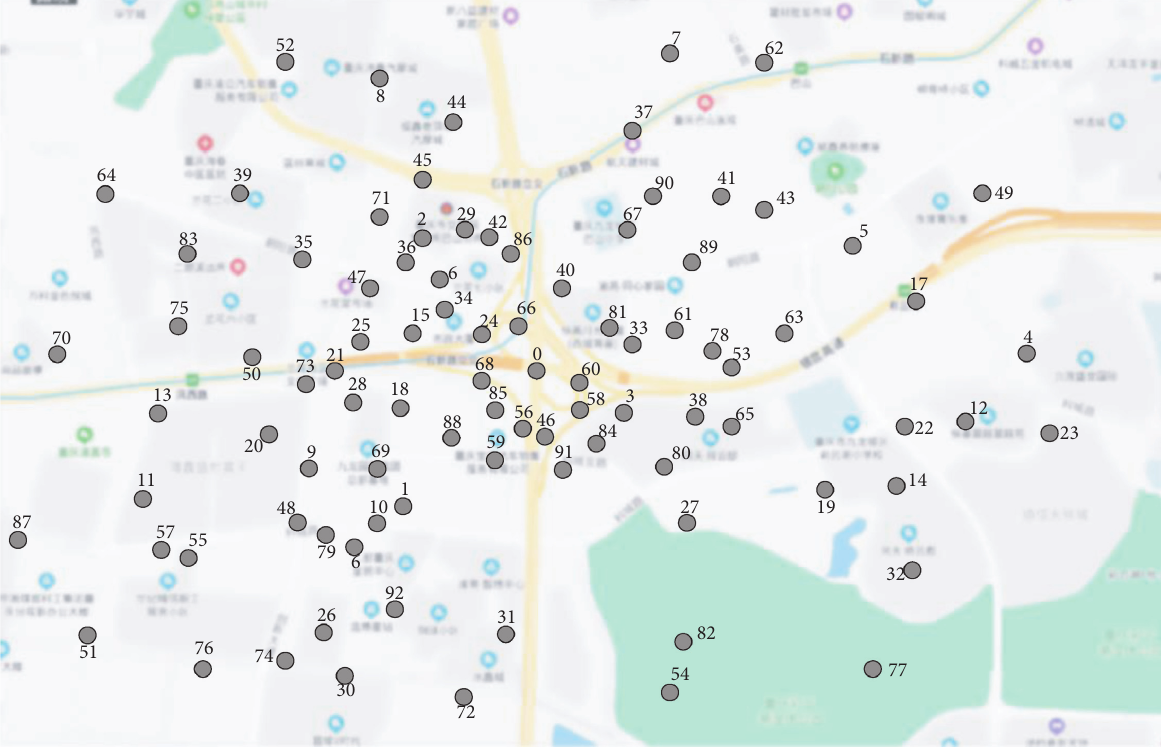
Figure 7: The spatial distribution of 46 orders.